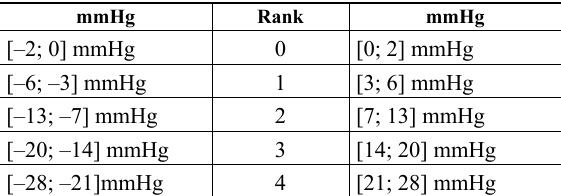
Table. Ranked values of spinal